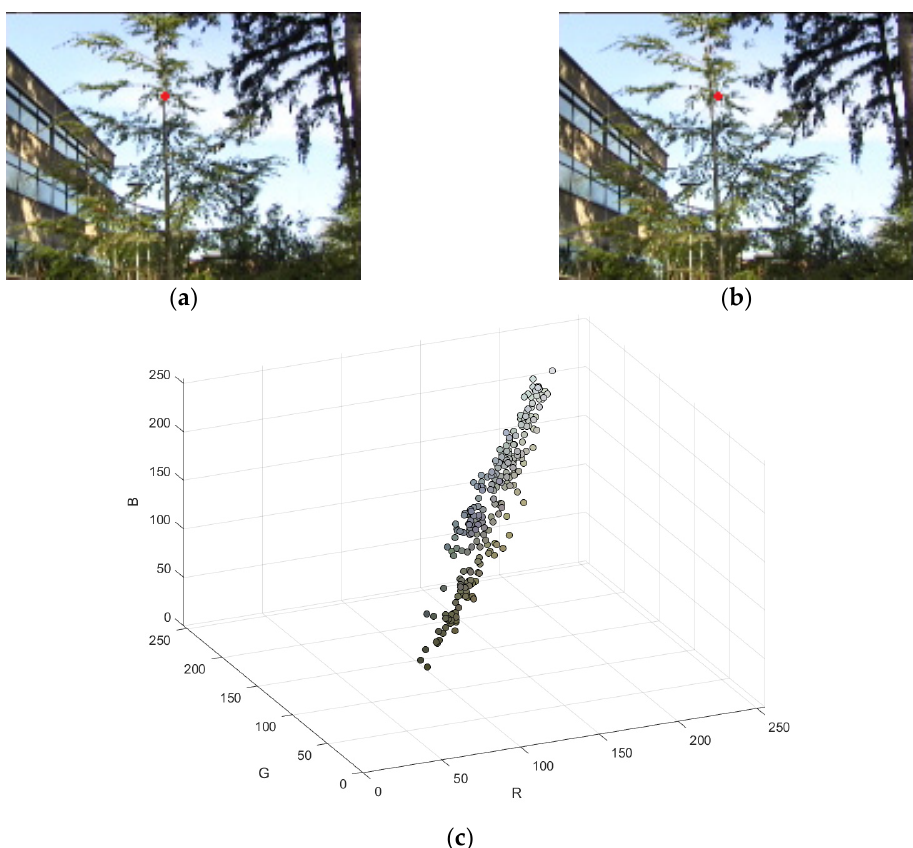
Figure 3. The color change of a video series at the sampling position (100, 40): ( a ) the first input image, ( b ) the 100th input image, ( c ) the 250th input image, with the red dot on the diagram representing the sampling position, ( d ) color distribution of the first to 100th input images, and ( e ) color distribution of the first to 250th input images.